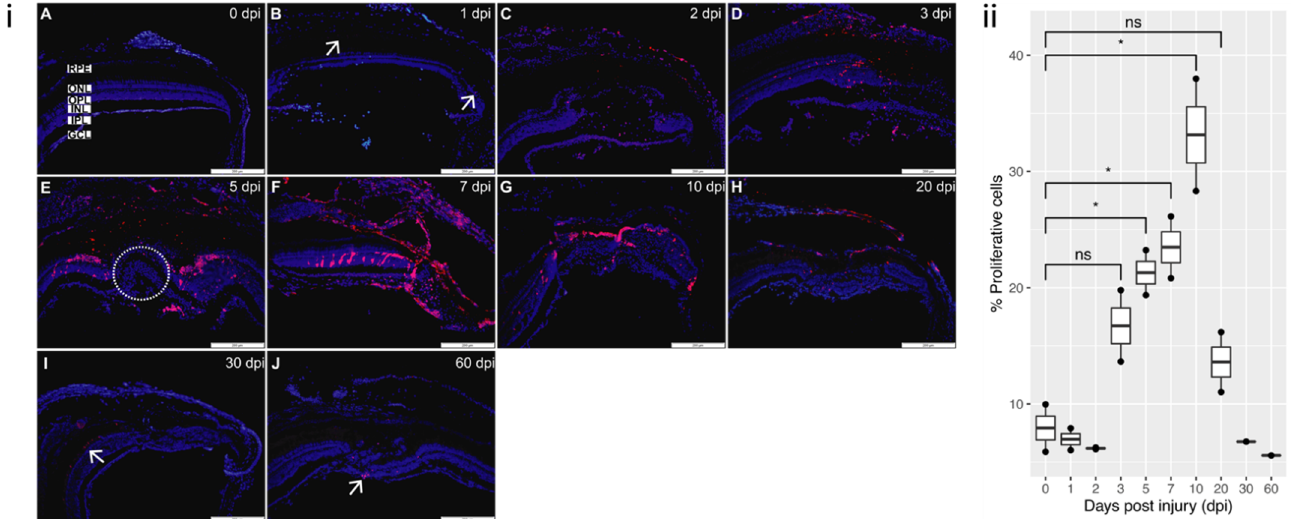
Figure 4. PCNA staining of proliferation: (i) ( A ) Proliferation is minimal in the control uninjured retina (0 dpi). ( B ) 1 dpi: proliferation begins to be detected (arrows). ( C , D ) 2 dpi and 3 dpi: proliferation more evident at the lesion site. ( E ) 5 dpi: proliferation pronounced, with positive nuclei located predominantly in the ONL at the lesion margin, absent in the lesion site (circled). ( F ) 7 dpi: proliferation now detected throughout the lesion. ( G , H ) 10 dpi and 20 dpi: proliferation started to decrease as new cells have started to repopulate the lesion site. ( I , J ) 30 dpi and 60 dpi: proliferation now only marginally detected (arrows). All sections were counterstained with DAPI. PCNA proliferation marker—red; Nuclei, DAPI—blue. Retinal layers labelled in control panel for reference; RPE—retinal pigment epithelium, ONL—outer nuclear layer, OPL—outer plexiform layer, INL—inner nuclear layer, IPL—inner plexiform layer, GCL—ganglion cell layer. Scale bars represent 200 µm. (ii) Relative percentage of proliferative cells at each time-point (n = 2), * p value < 0.05.